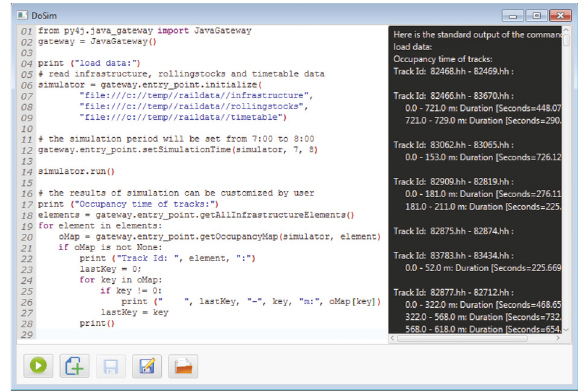
Figure 9: User interface for accessing Java services from Python in PULSim (Py2J).